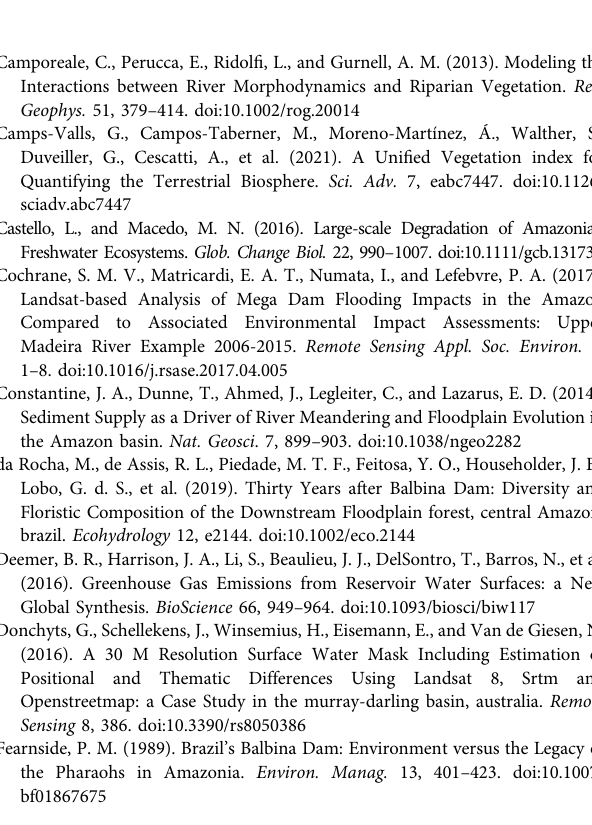
Supplementary Figure S3 – S8 : Esri, DigitalGlobe,